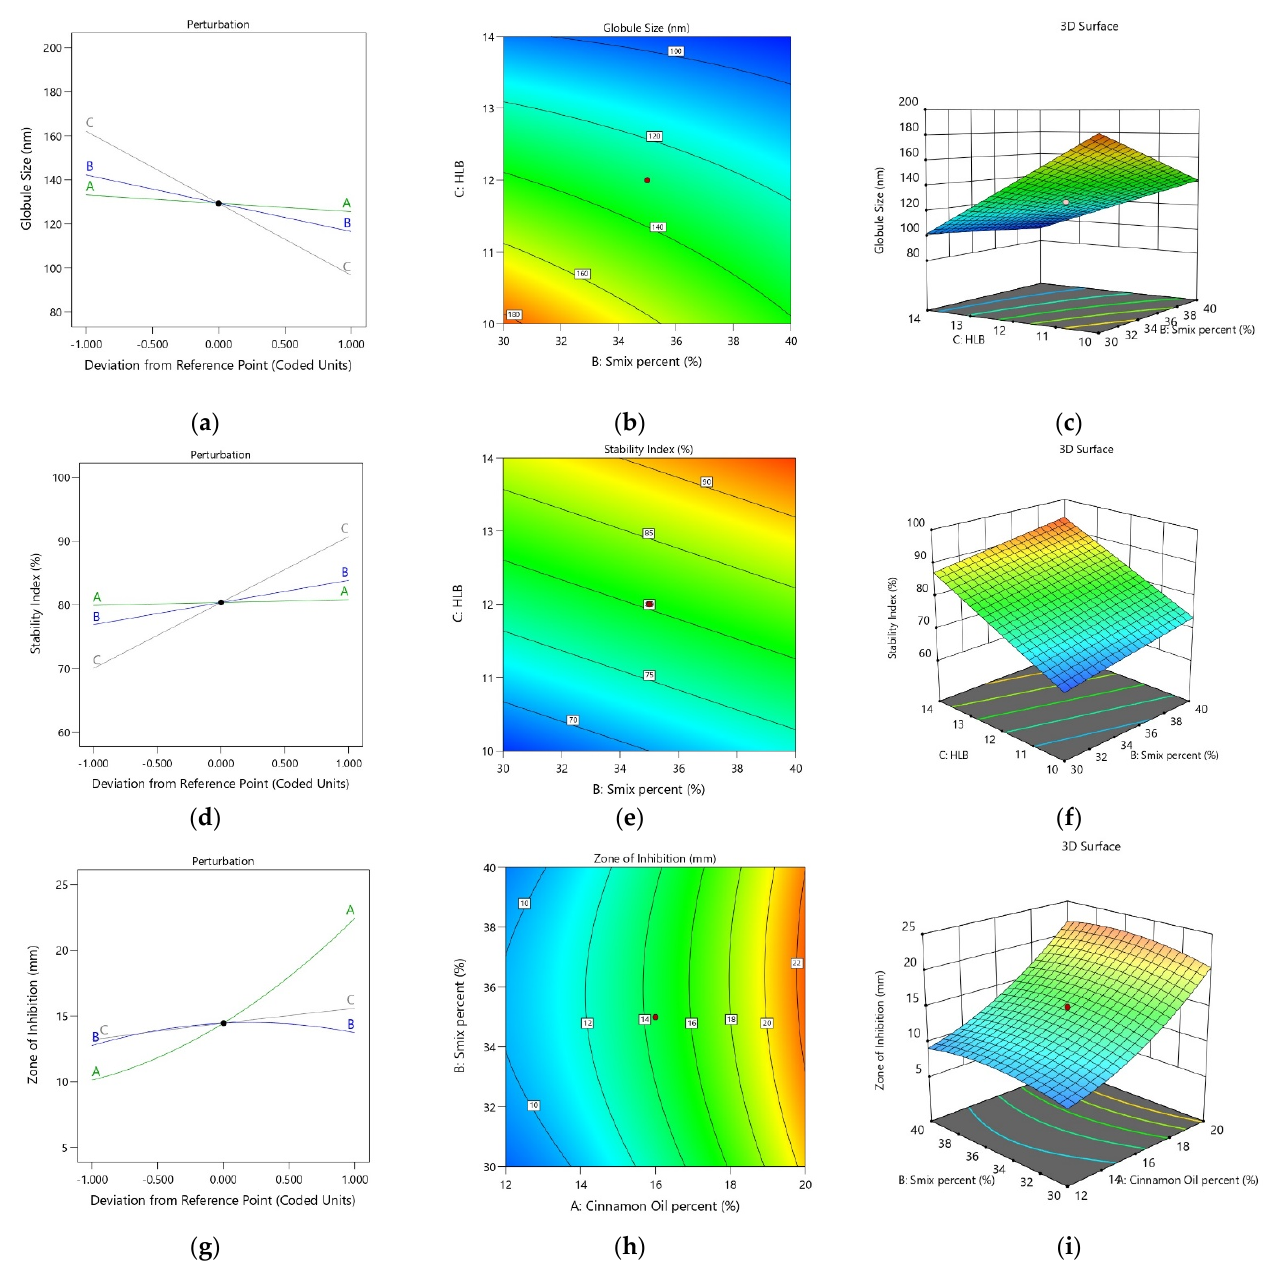
Figure 2. Statistical design plots for the droplet size, stability index, and zone of inhibition of CO-NE: ( a ) perturbation plot for globule size, ( b ) contour plot for droplet size,( c ) response surface plot for droplet size, ( d ) perturbation plot for stability index, ( e ) contour plot for stability index, ( f ) response surface plot for stability index, ( g ) perturbation plot for the zone of inhibition, ( h ) contour plot for the zone of inhibition, and ( i ) response surface plot for the zone of